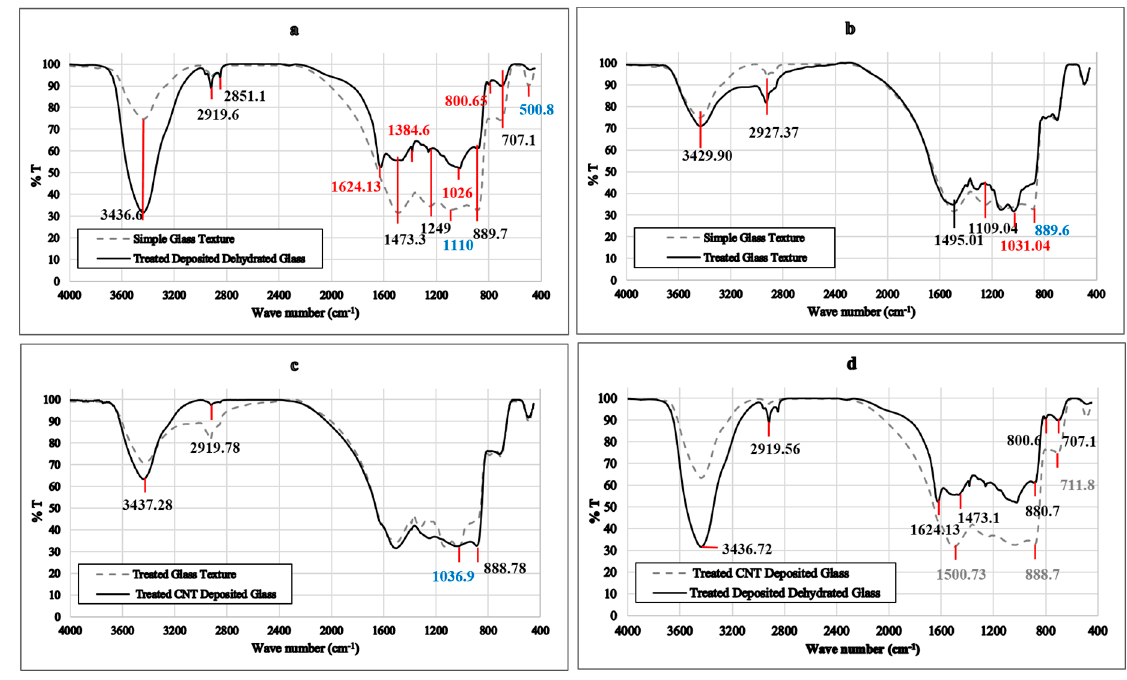
Figure 3. Fourier-transform infrared (FTIR) spectroscopy of GTs at different stages of treatment and